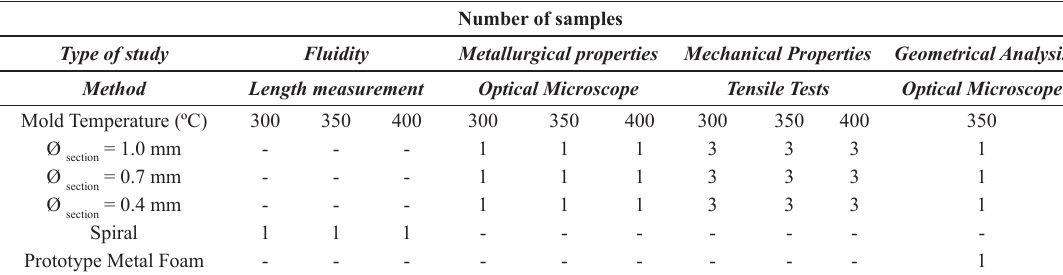
Table 4. Number of samples used in each type of study.